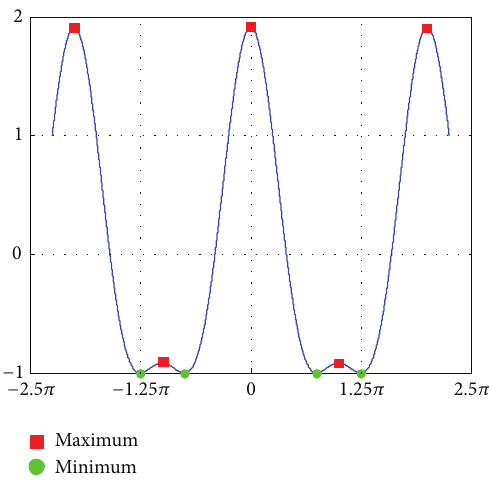
Figure 4: Extrema points in 2D.